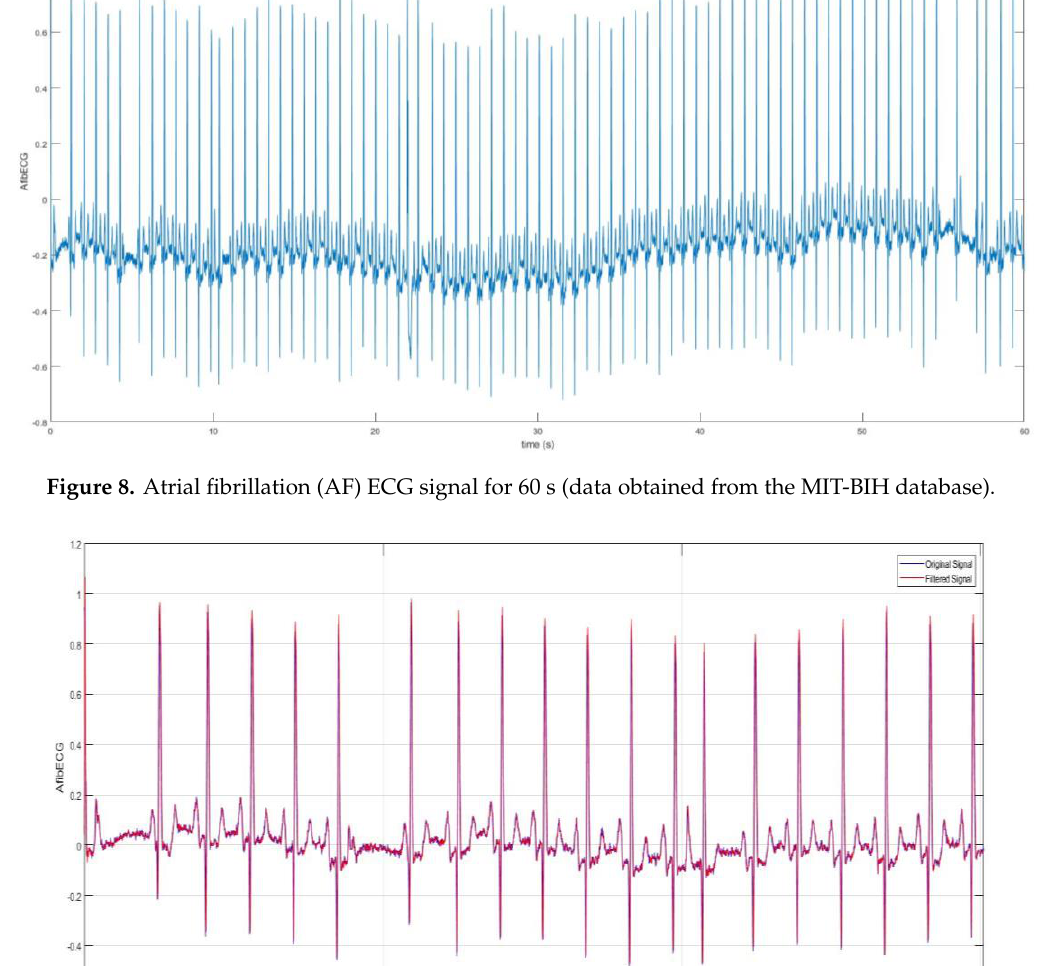
Figure 10. Comparison of characteristics of AF and healthy ECG signals (10 s). Next, the BPM for the AF ECG signal was determined. Figure 11 shows a way to detect the QRS peak and to find the BPM for the both healthy and AF ECG signals. Figure 11a,b shows 70 and 122 BPM, respectively, which also proves the rapid heart rate, one of the main characteristics of AF.